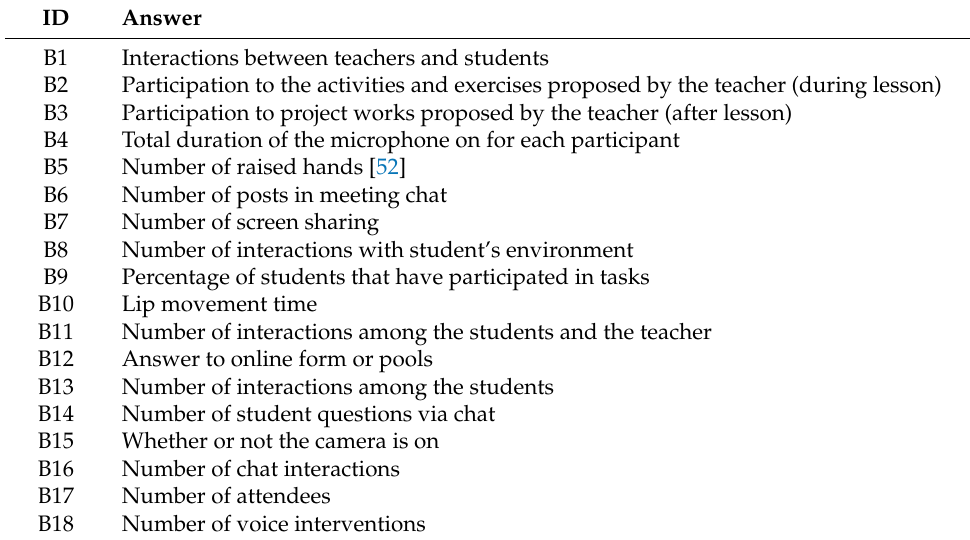
Table 1. Answers from the behavioral engagement